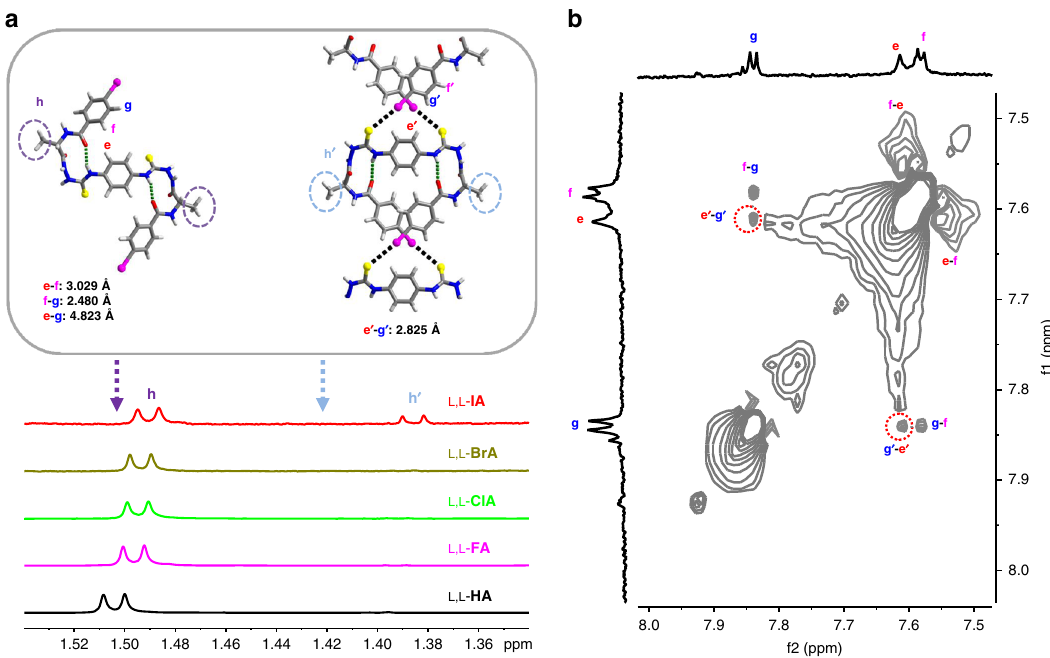
Fig. 4 1 H NMR studies. a Partial 850 MHz 1 H NMR spectra of – CH 3h in L,L- XA in CD 3 CN at 25 °C. The solutions were samples saturated. Dashed arrowed lines illustrate DFT calculated chemical shifts of the – CH 3 groups in the monomer of L,L- IA in the trans -form (1.50 ppm) and in the oligomers of L,L- IA in the cis -form (1.42 ppm) that support the assignments of the 1 H NMR signals of – CH 3 groups. The structures with protons and distances labeled are also shown. Method for NMR calculation: DFT OPBE with the 6 – 311 + G(2d, p) basis set for C, H, O, N, and S atoms, and LANL2DZ for I atom. b Expanded 2D NOESY spectrum (850 MHz, 25 °C, mixing time 800 ms) of couplings between protons in phenyl rings in L,L- IA molecules in CD 3 CN at 5.6 μ